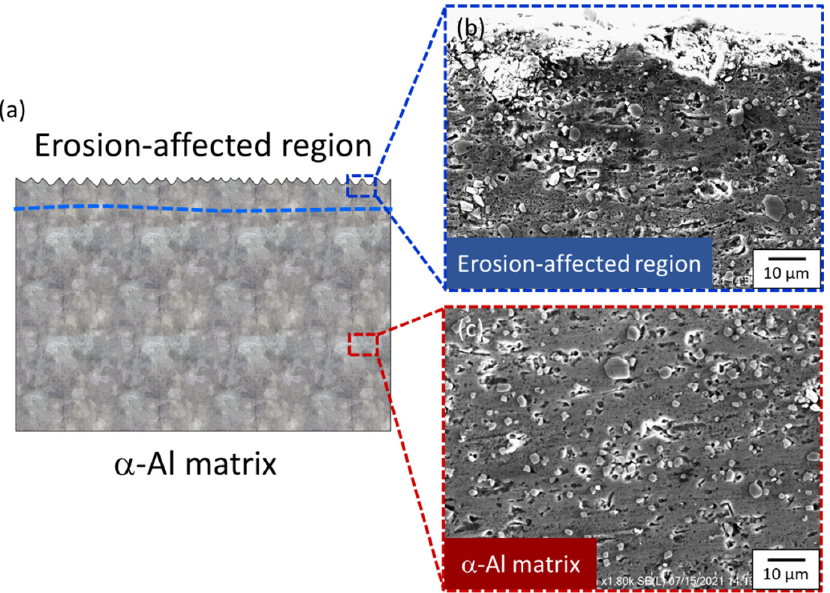
Figure 10. ( a ) The schematic diagram of the erosion-affected region and α -Al matrix, the SEM image of ( b ) the erosion-affected region, and the ( c ) α -Al matrix.